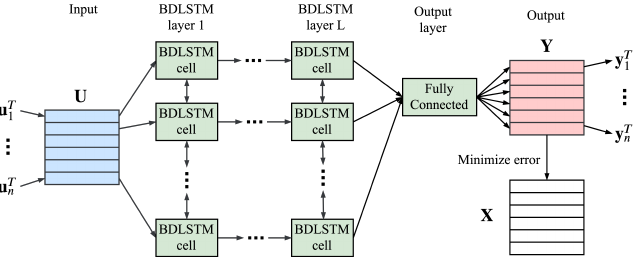
Figure 4. Proposed BDLSTM